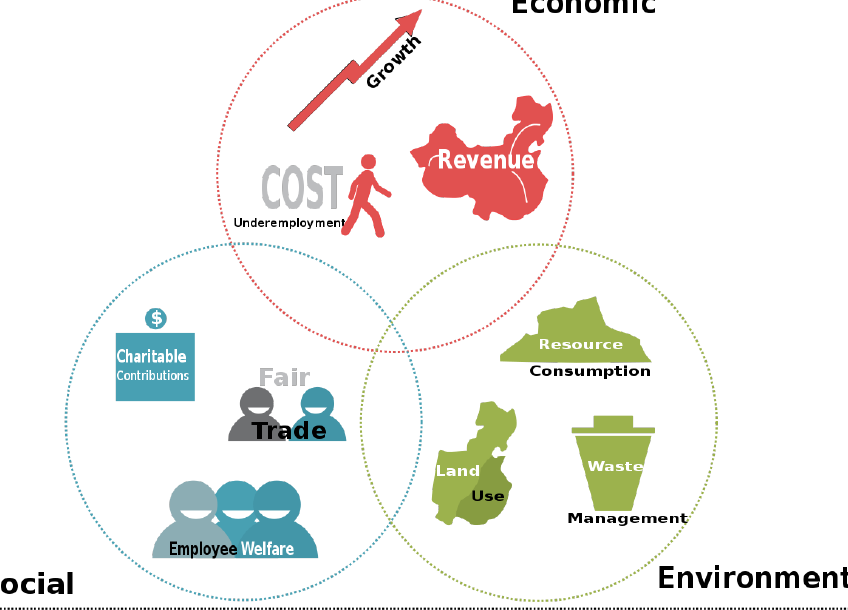
Figure 1. Graphic describing the three types of bottom lines.